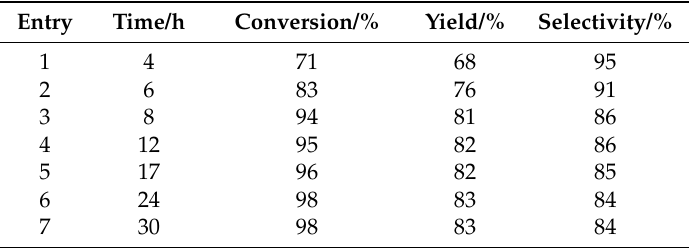
Table 2. Conversion of cyclohexanol into cyclohexylamine over Raney Ni with different time. Entry